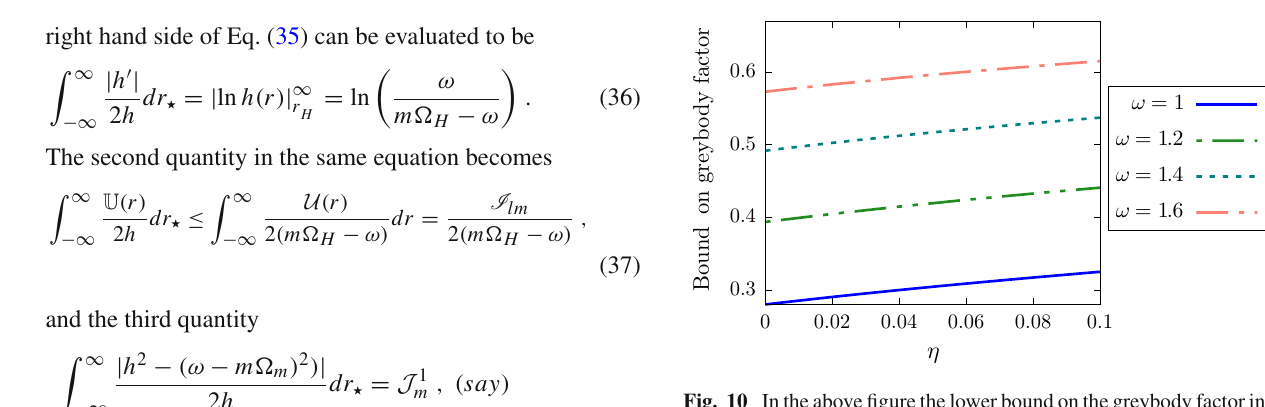
Fig. 10 In the above figure the lower bound on the greybody factor in a radially deformed Schwarzschild BH spacetime is plotted with respect to varying η for different fixed ω . We have set the other parameters at l = 1, and r s = 1